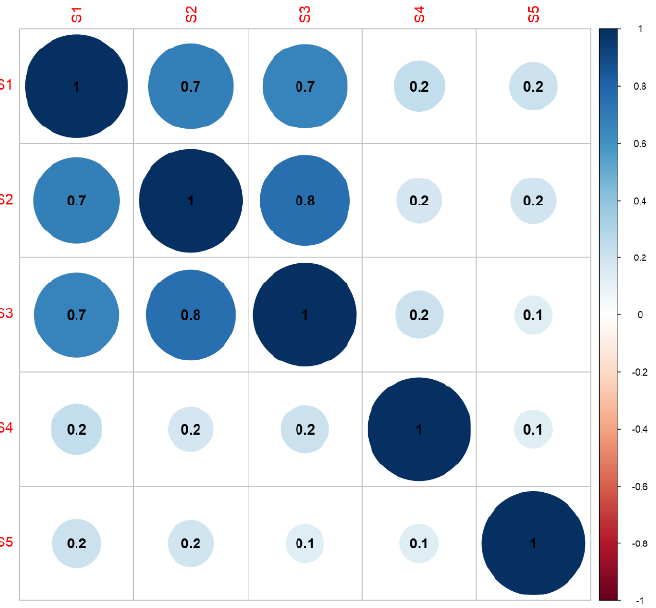
Figure 5. Matrix of correlation of energy consumption in technological processes for onion pro- cessing.